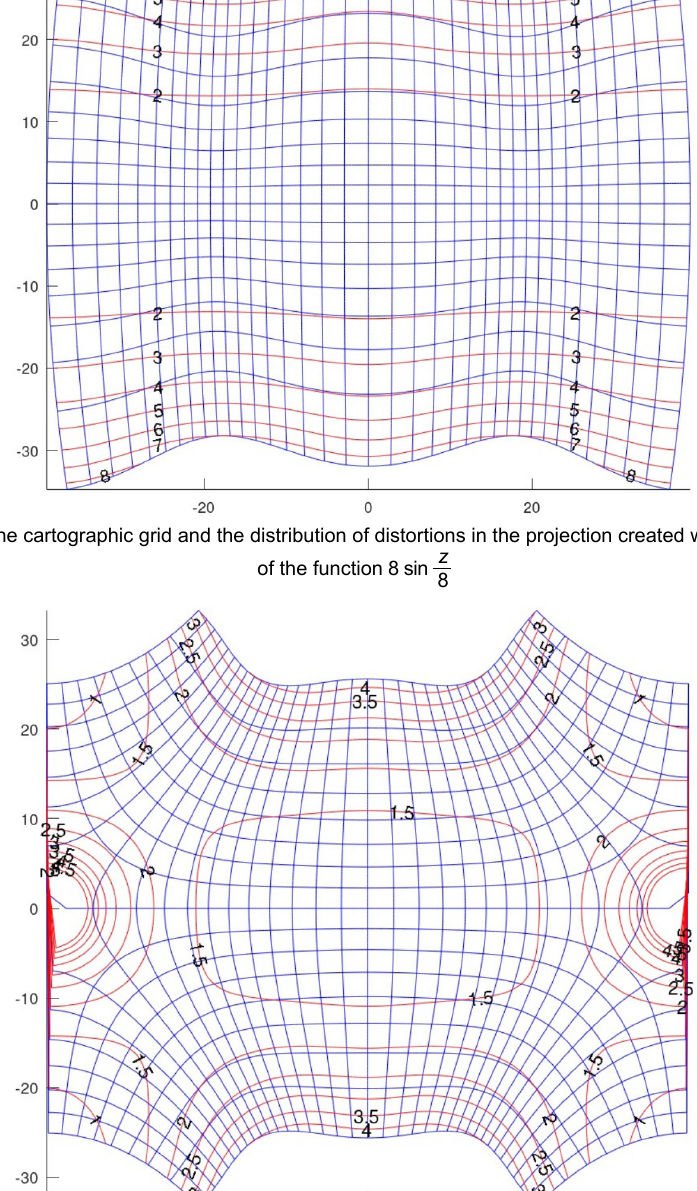
Fig. 17. The cartographic grid and the distribution of distortions in the projection created with the use z of the function 2 arcsin